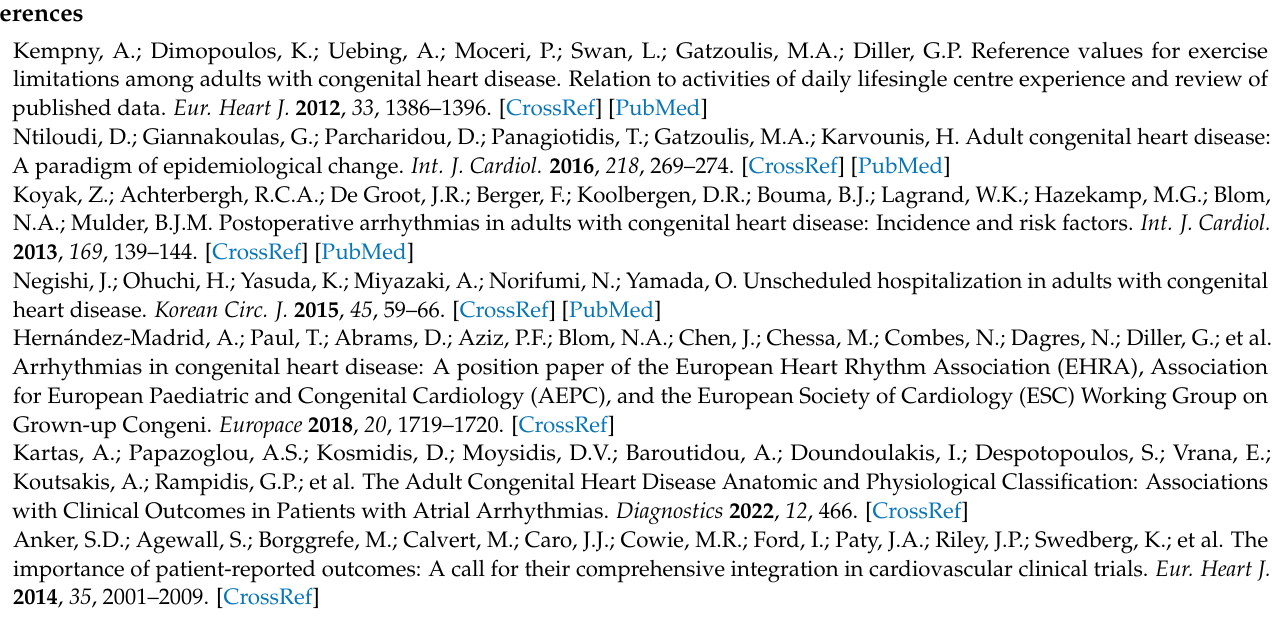
Table S1: Hazard ratios for outcomes at a median 20-month